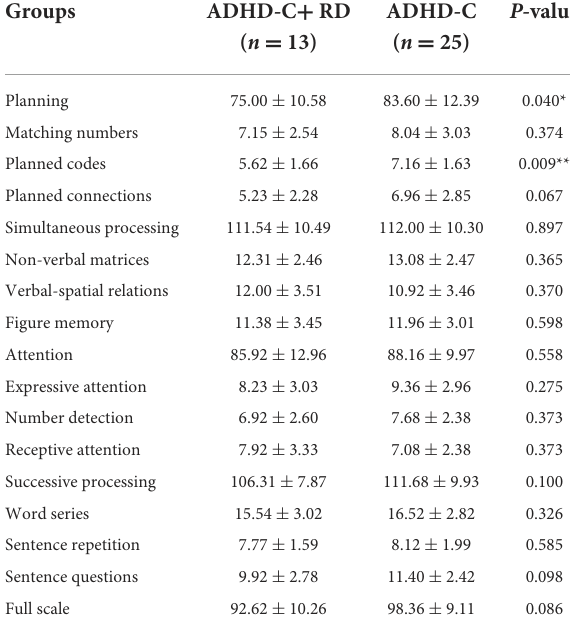
TABLE 2B DN: CAS full scale and subscale scores for ADHD-C + RD subgroup and ADHD-C subgroup. Groups